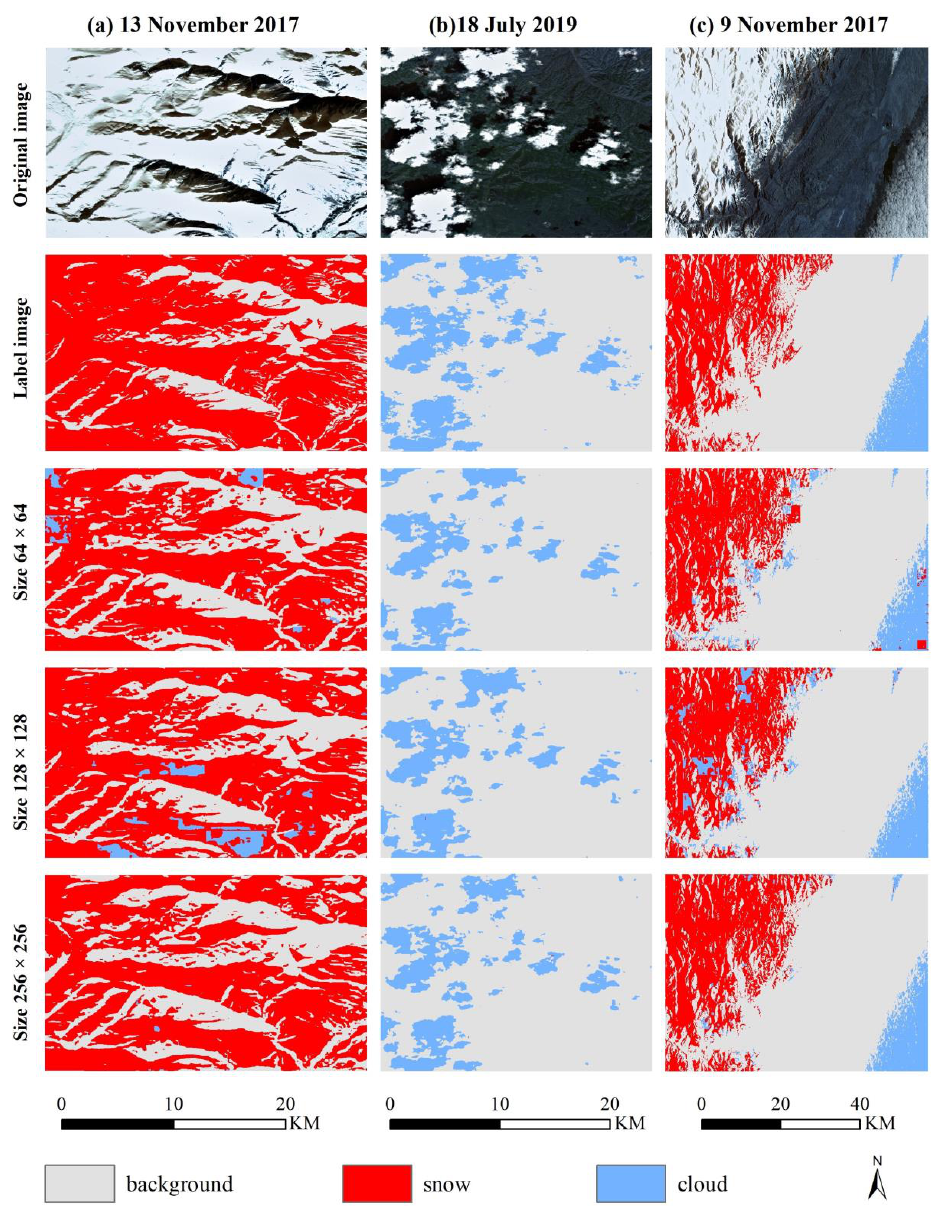
Table 4. Comparison of model test accuracy under different sample sizes.